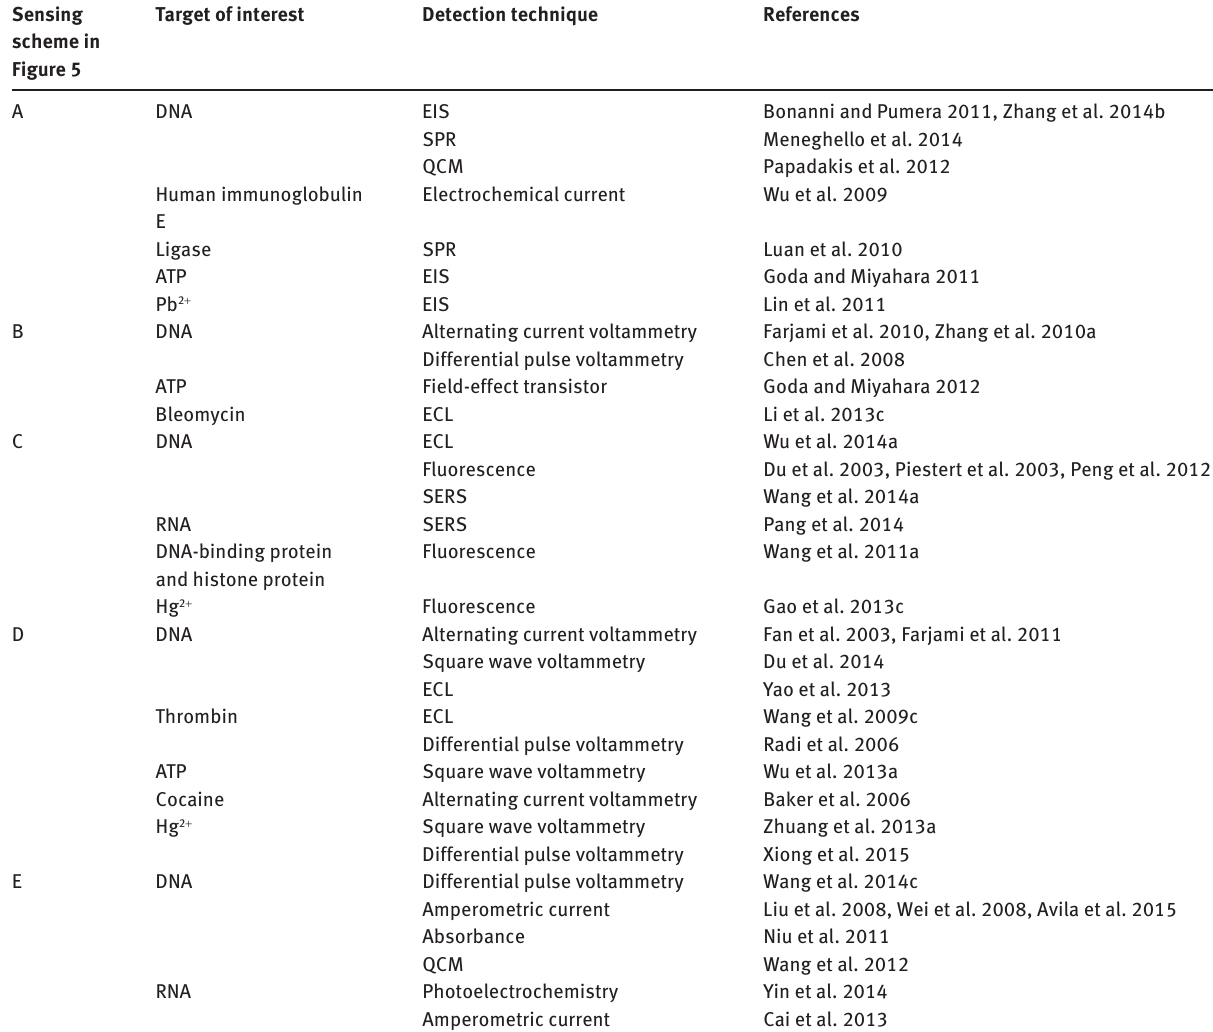
Table 4: HDP-based solid-phase platforms for detecting a wide range of analytes. Sensing Target of scheme in Figure 5